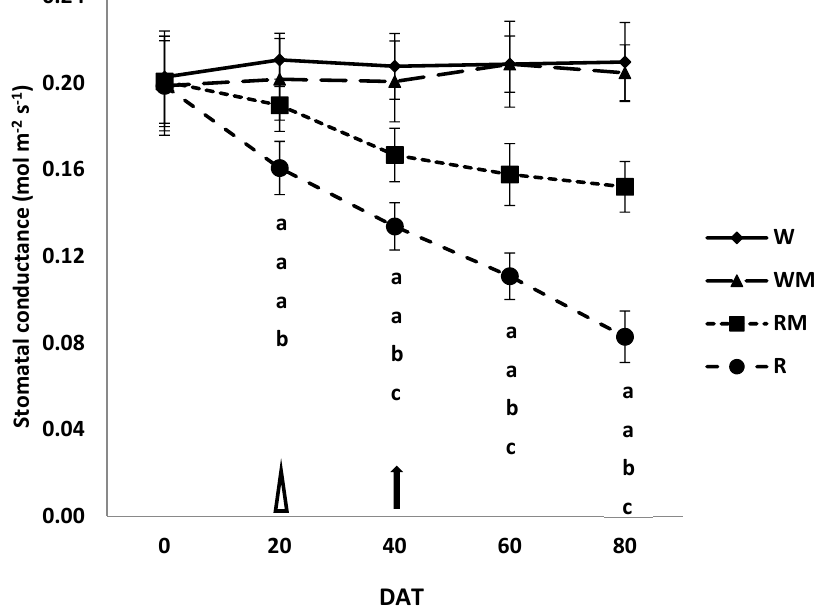
Figure 4. Changes in stomatal conductance (mol m − 2 s − 1 ) of spearmint exposed to the following treatments: R—rainfed without straw mulch, RM—rainfed with straw mulch, W—well-watered control plants and WM—well-watered with straw mulch. Measurements were performed 0, 20, 40, 60 and 80 days after the onset of the treatments (DAT). Vertical bars represent ± SE of the mean ( n = 5). Bars with different letters indicate significant differences among treatments in the given DAT at p ≤ 0.05. Triangle at 20 DAT indicates the early bloom, and arrow at 40 DAT indicates the full bloom, in overall